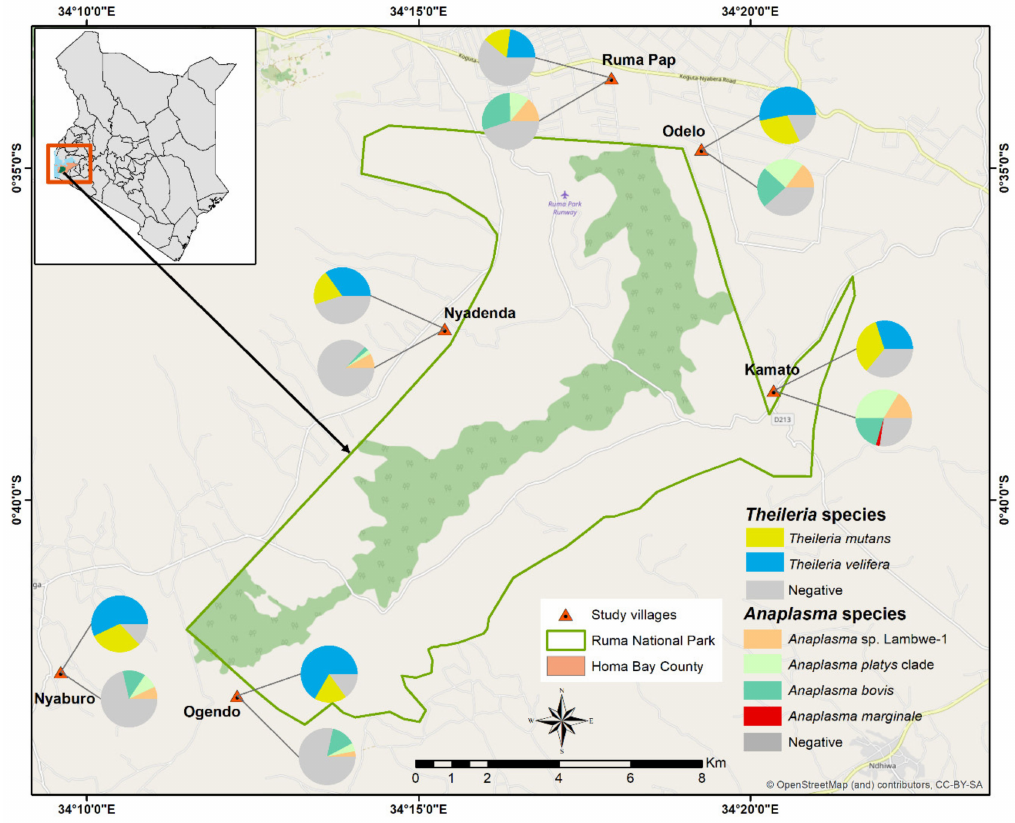
Figure 1. Livestock sampling and tick-borne pathogen (TBP) prevalence map across the the study villages of Lambwe Valley in western